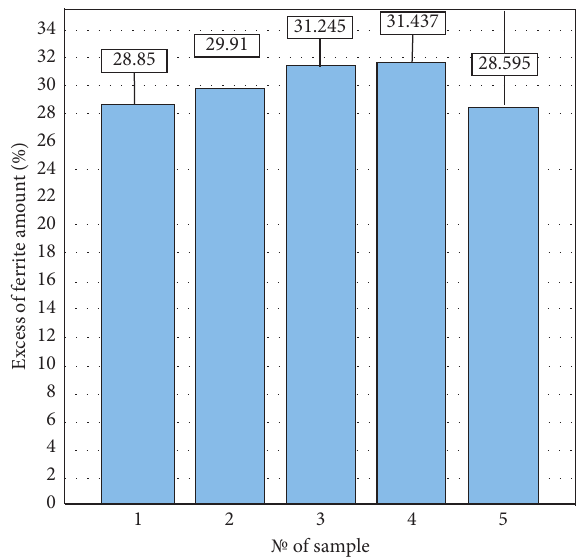
Figure 22: The distribution of the excess ferrite amount in the deposited steel S 45 samples after treatment with high-frequency currents and air cooling.